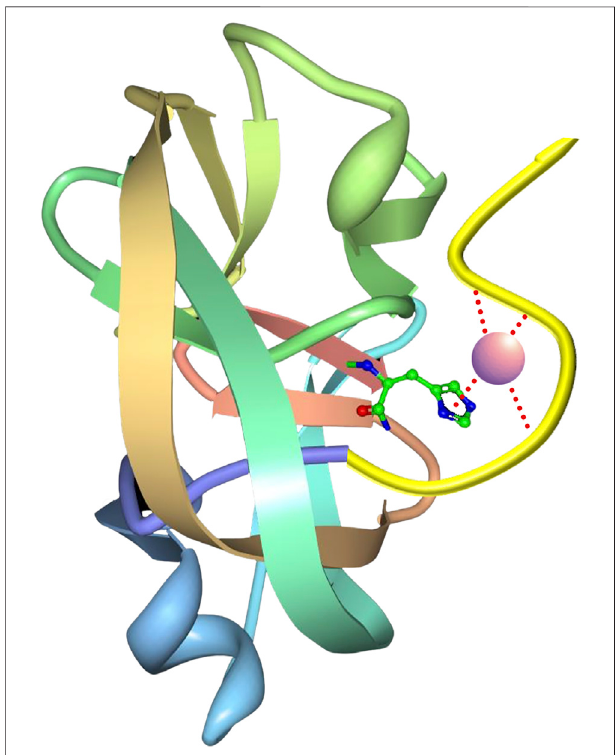
FIGURE 10 | Ribbon diagram of the Δ I-CM mini-intein with an engineered N-terminal zinc binding motif and bound zinc ion interactingwith a conserved His residue (ball-and-stick) close to the C-terminal cleaving junction.Ifproperlydesigned,thismotifwillgreatlyincreasetheaf fi nityfor zinc by the intein, allowing a much higher sensitivity to zinc for suppressing cleaving during expression and puri fi cation of a fused target protein. The resulting intein is described in the associated patent (Ma et al., 2019; Patent No.: US 10323235 B2; prioritized in 2012, fi led in 2017 and approved in 2019).The structure ofPDBID 2IN0 isherepresented(Van Roeyet